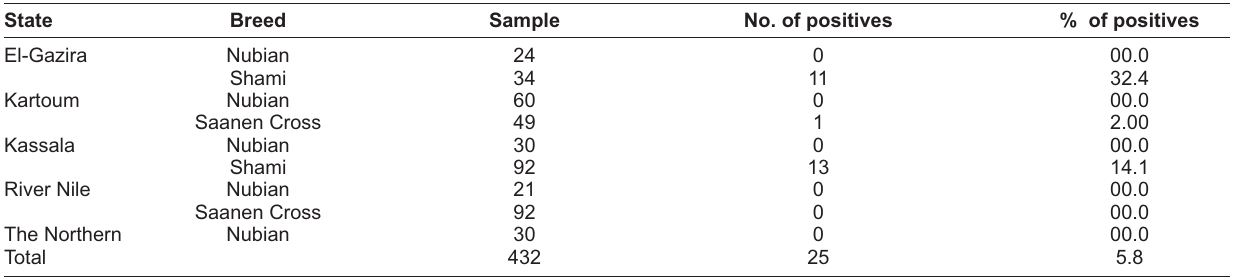
Table-2. Seropositivity to CAEV infection in goats breeds detected by cELISA from different states in Sudan